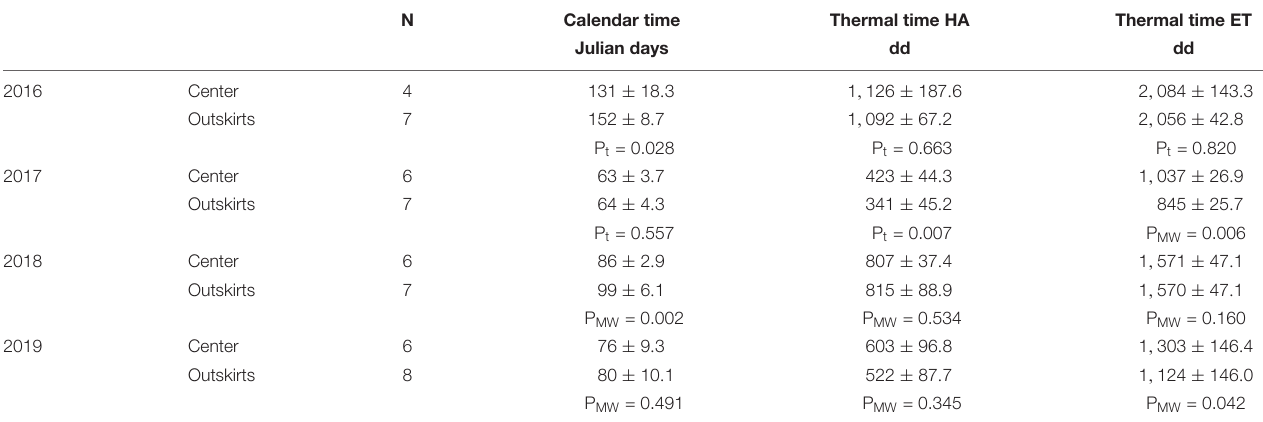
N—number of populations used in the study. P—the significance of differences calculated using the t-test (Pt) or the Mann-Whitney test (PMW).